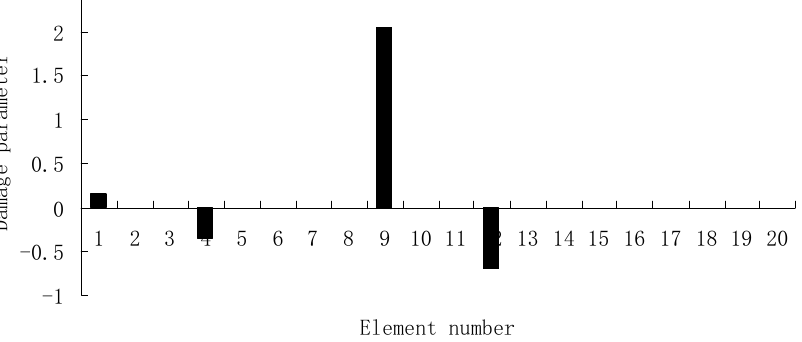
Figure 23. Damage evaluation result by the second computation of ESVT for the experimental beam.